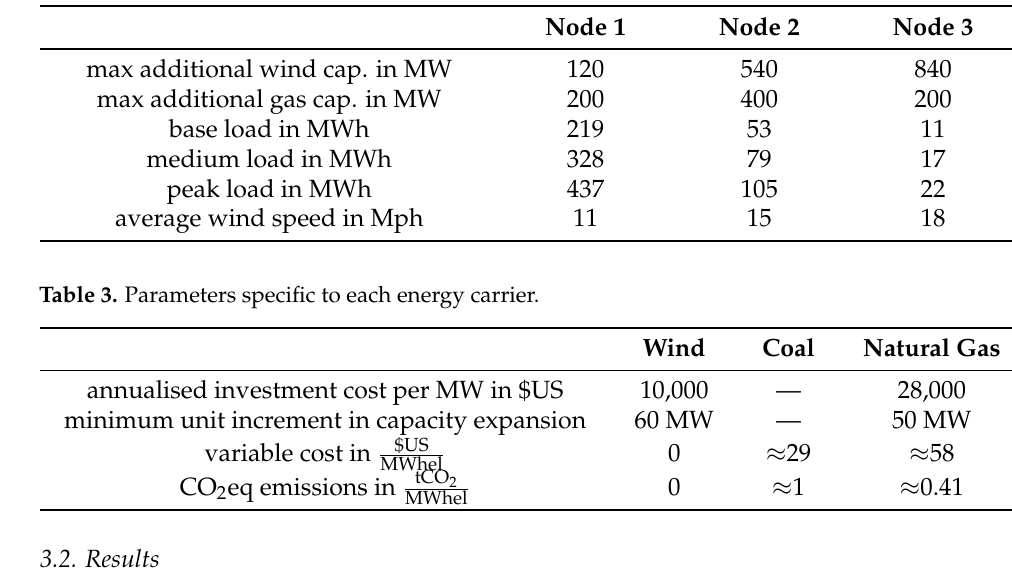
Table 2. Investment and cost parameters.